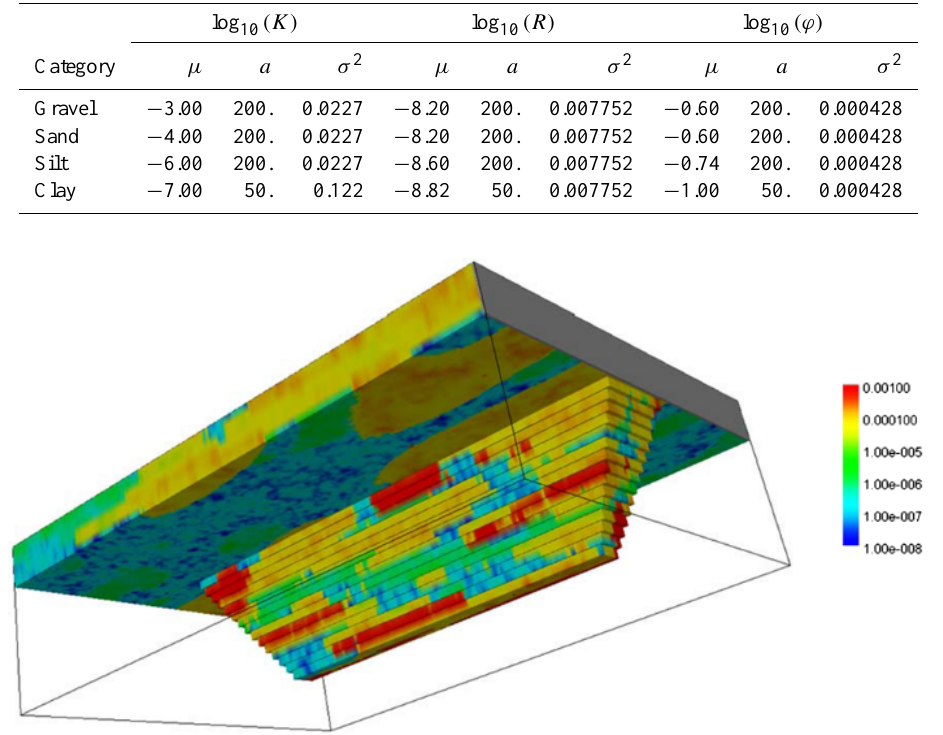
Figure 3. Hydraulic conductivity field for one of the model realizations. (Red shades are for gravel, yellow for sand, green for silt, and cyan/blue for